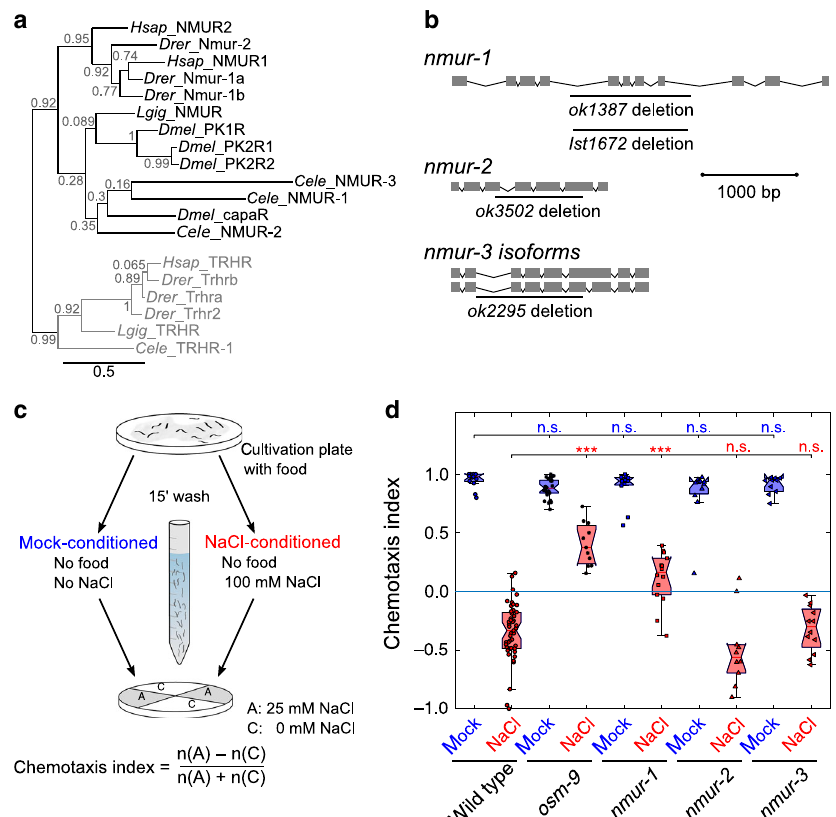
Fig. 1 The C. elegans neuromedin U receptor ortholog nmur-1 regulates gustatory aversive learning. a Maximum likelihood tree of the phylogenetic relationship between neuromedin U receptor (NMUR) orthologs of C. elegans ( Cele ), D. melanogaster ( Dmel ), L. gigantea ( Lgig ), D. rerio ( Drer ) and human ( Hsap ). Thyrotropin-releasing hormone receptors (TRHRs) are used as outgroup to root the tree, because this receptor family was shown to be most related to bilaterian NMURs 7 . Branch node labels correspond to likelihood ratio test values. b Gene organization of three predicted nmur orthologs in C. elegans , named nmur-1 to nmur-3 . Boxes represent exons and lines show intronic sequences. Bars indicate the position of deletions in loss-of-function